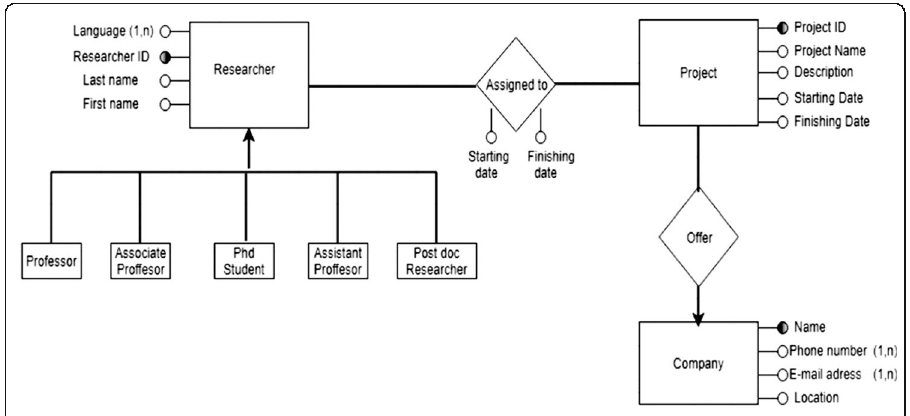
Fig. 5 The Entity-Relationship Diagram using Visual paradigm database online design tool